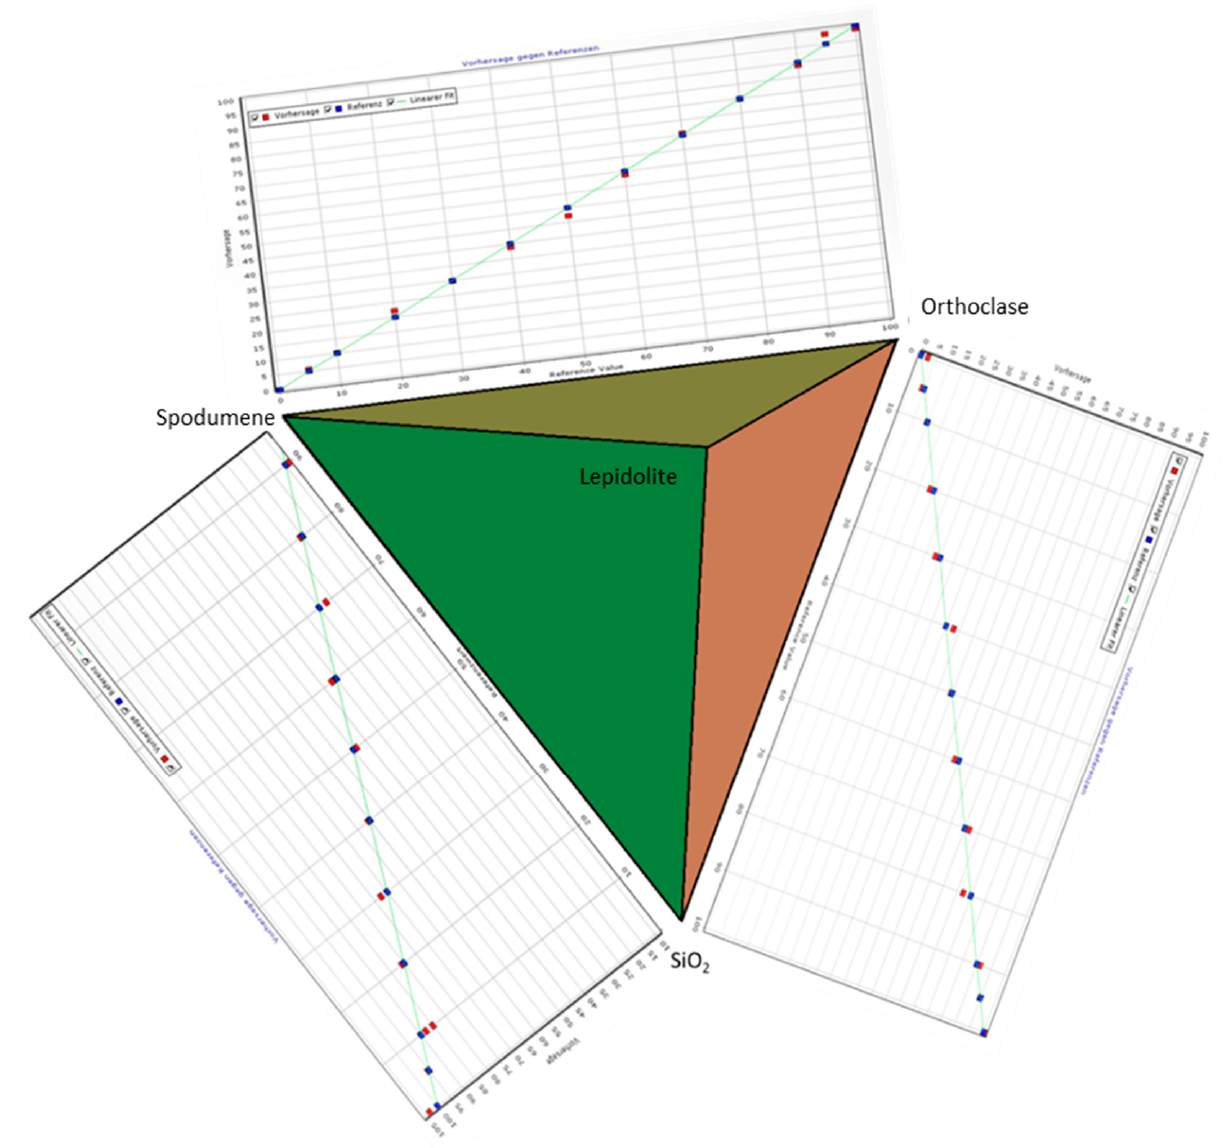
Figure 30. Calibration curves of the three binary mixtures in the system quartz-feldspar-spodumene arranged along the triangle spodumene-quartz-orthoclase.